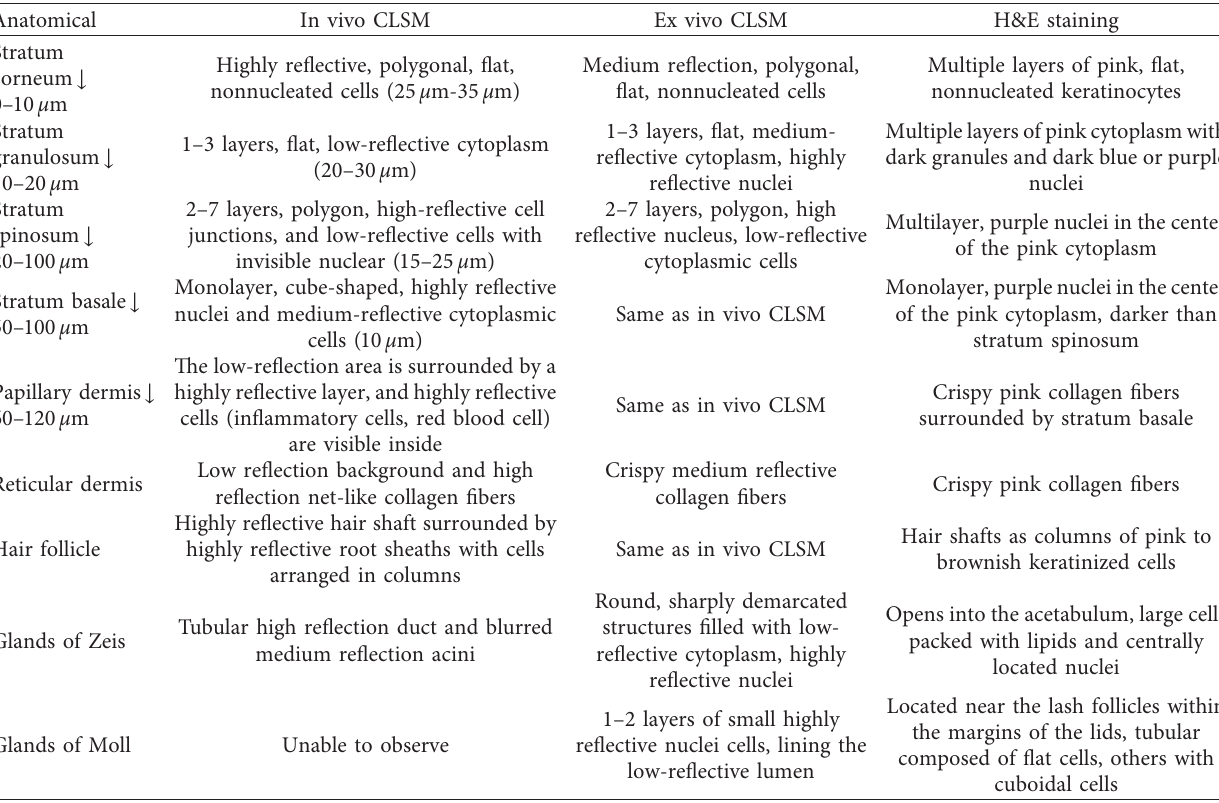
Table 1: List of in vivo and ex vivo CLSM features of healthy skin part of the eyelid margin and their histological correlates in H&E staining. Anatomical